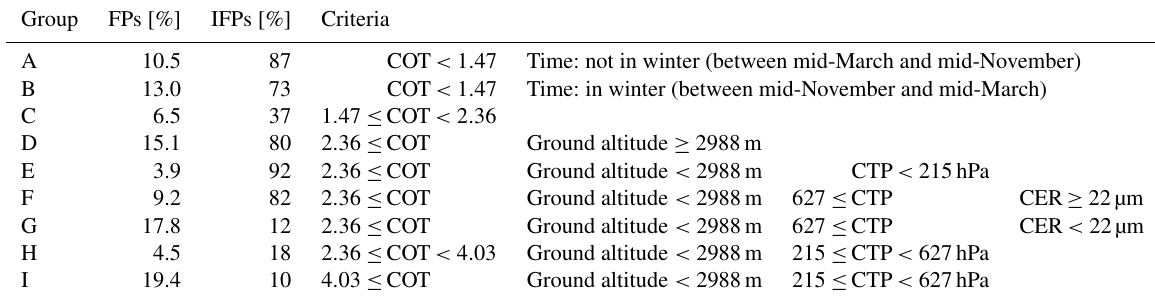
Table 2. Main branches of the tree. The letters in the first column correspond to the groups circled in Fig. 10. The second column states the amount of false positives (FPs) in the satellite data falling into each branch; the third one states how many of them were correctly identified by the model (IFPs: identified false positives). The remaining columns describe the parameters and thresholds leading to each branch. COT: cloud optical thickness; CTP: cloud top pressure; CER: cloud effective